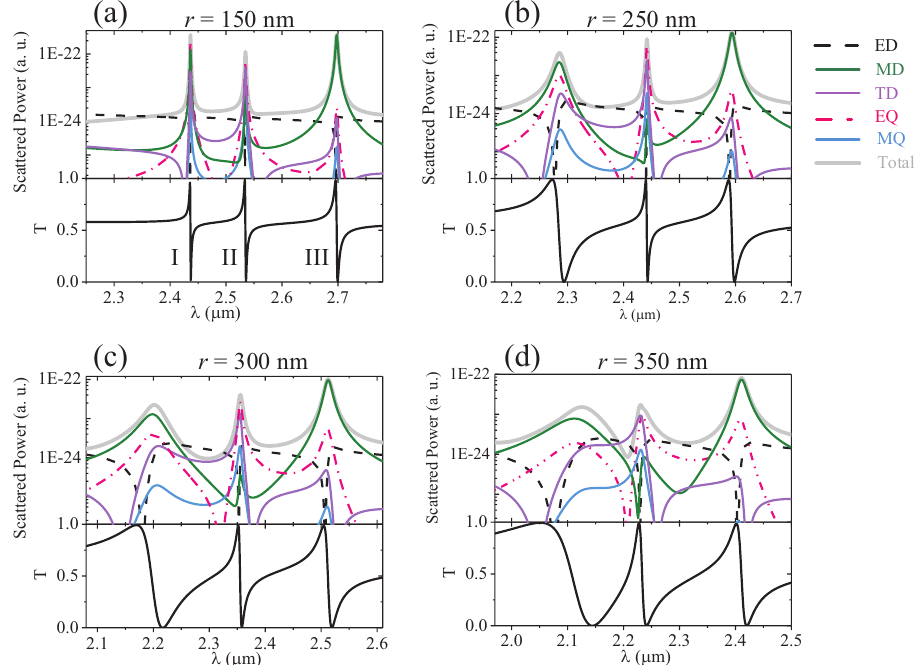
Figure 7. Total scattered power and contributions of different multipoles under different air-hole radii r